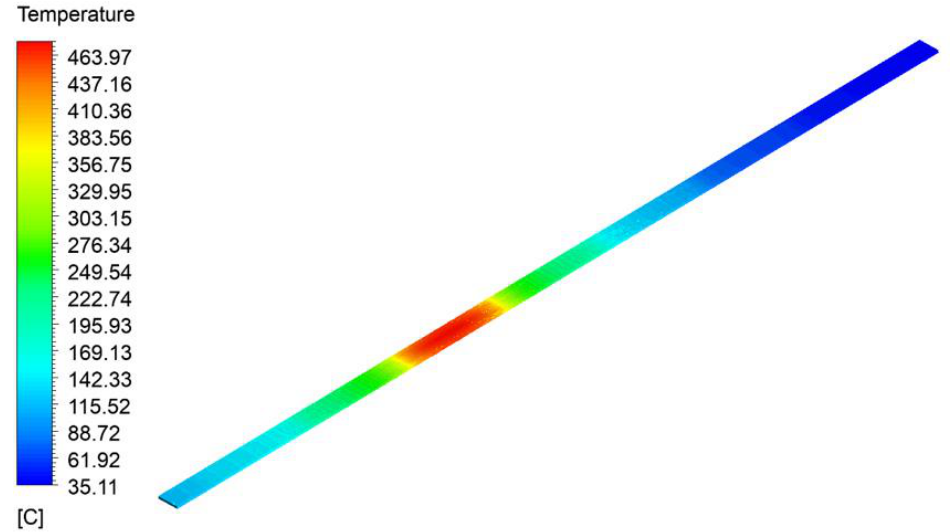
Figure 12. Overall temperature of the concrete track bed.